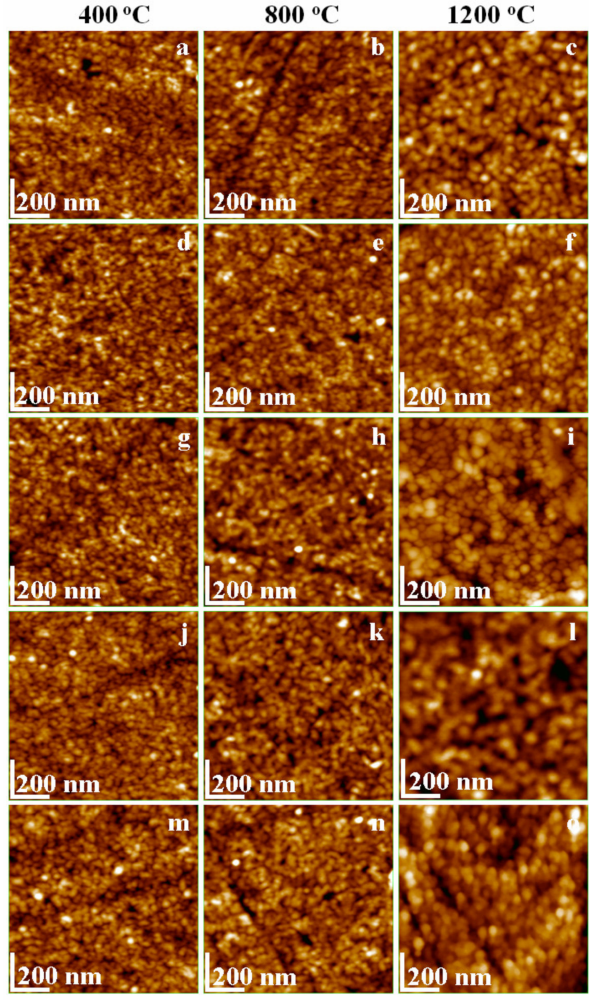
Figure 2. Topographical AFM images of Mn 1 − x Ni x Fe 2 O 4 @SiO 2 NCs annealed at 400, 800, and 1200 ◦ C (x = 0 ( a – c ), x = 0.25 ( d – f ), x = 0.50 ( g – i ), x = 0.75 ( j – l ) and x = 1.0 ( m – o )). Table 2. AFM parameters of Mn 1 − x Ni x Fe 2 O 4 @SiO 2